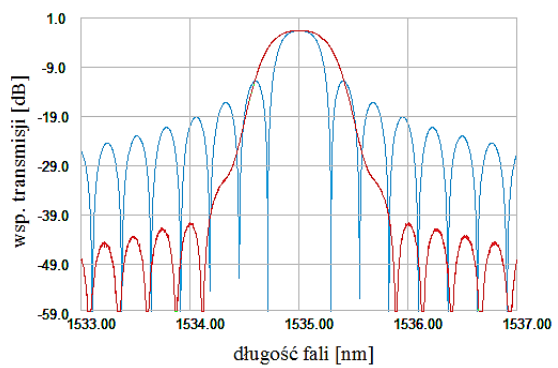
Fig. 8. Comparison of Bragg fiber gratings spectral characteristics without apodization – blue line and apodized Gauss function at а = 3 – red line.